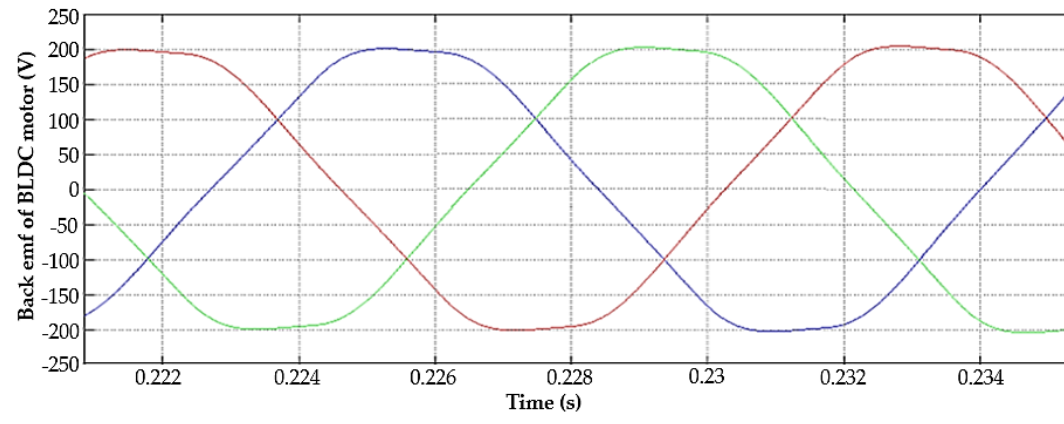
Figure 10. Steady-state response of the BLDC motor speed.